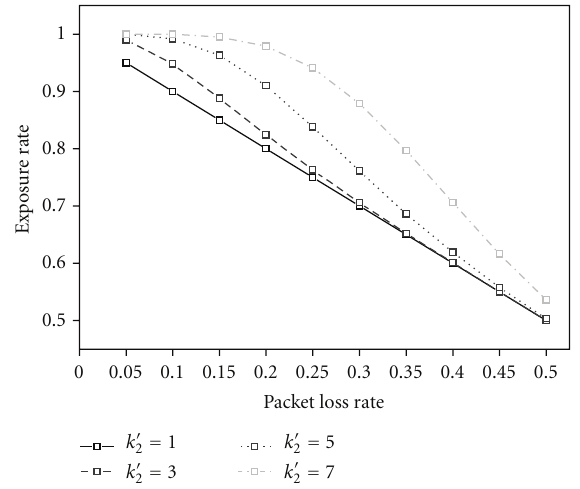
Figure 7: Exposure rate performances when di ff erent k (cid:3) 2 are applied to the secure FEC. This figure shows the performance impact as the reference packets are leaked to the malicious